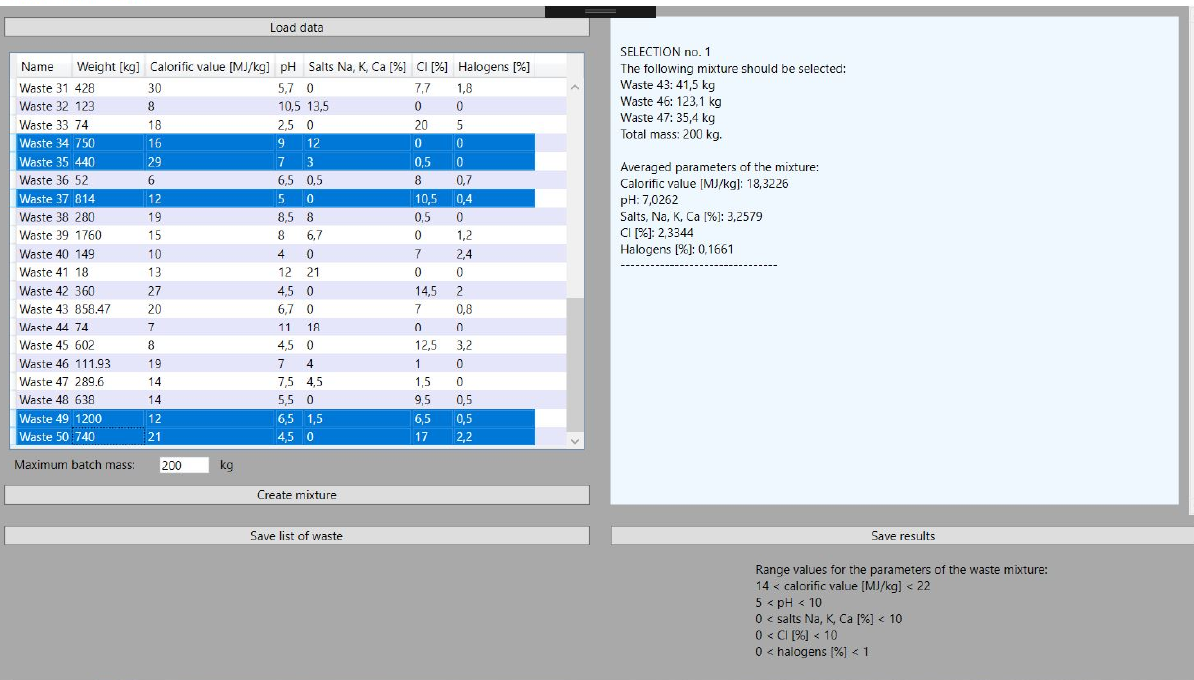
Figure 7. Selection of the next mixture from other types of waste.